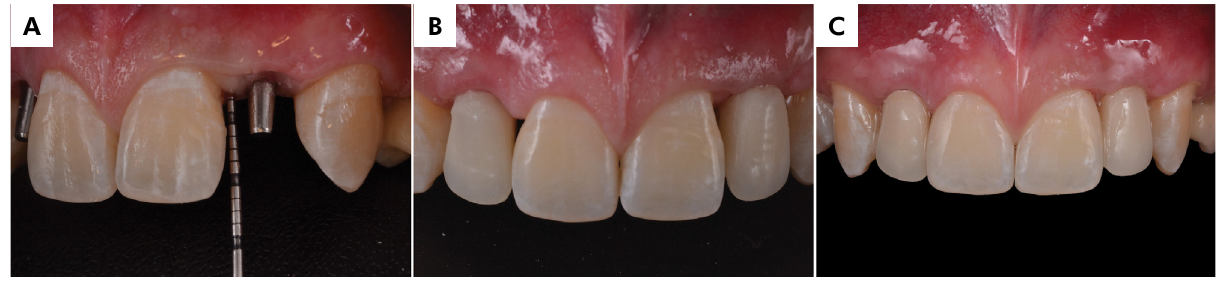
Figure 6. The distance between the bone crest and the tip of the papillae was 3 mm in height (a). The anatomy of the implants provisional restorations (b) and the distal aspect of the maxillary central incisors (c) were modified, and the contact point was shifted